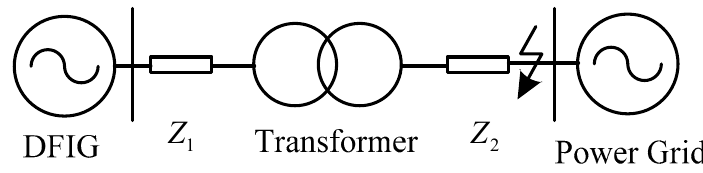
Figure 12. Simulation model of the DFIG.